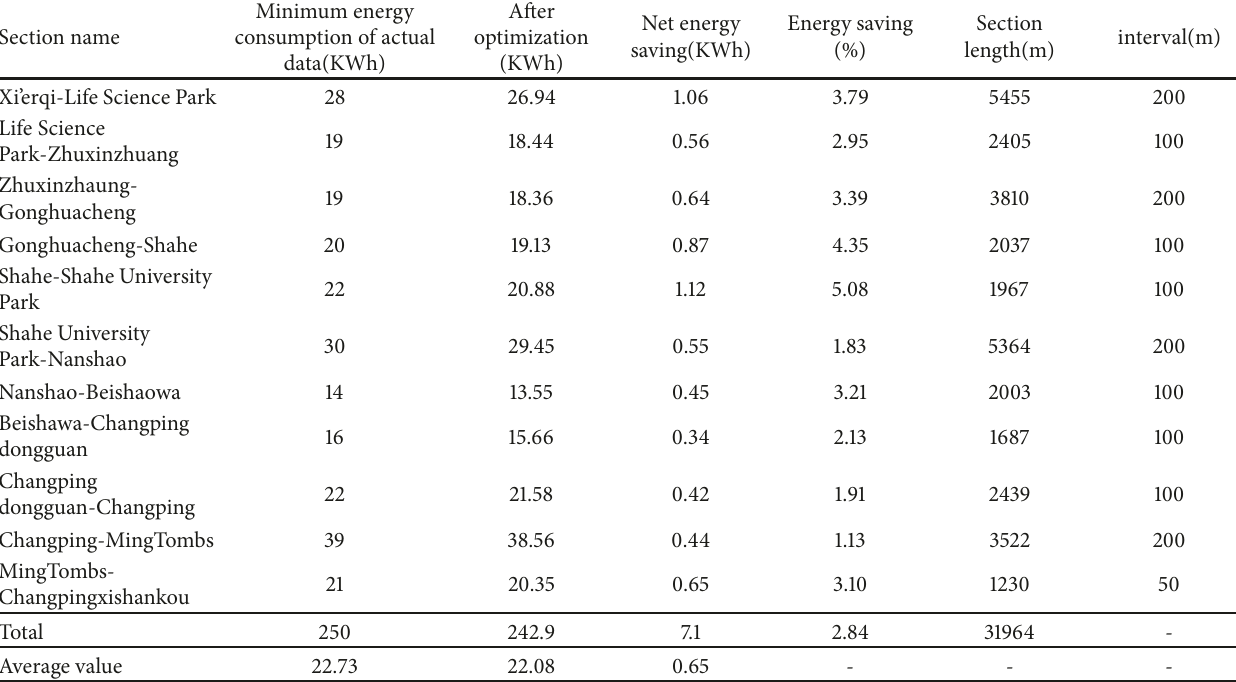
Table 6: Optimization results of other